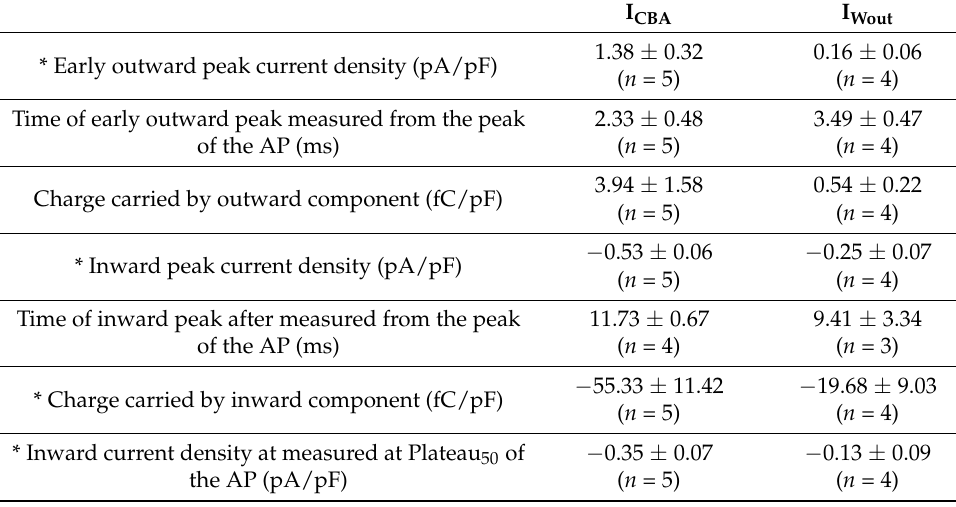
Table 2. Parameters of CBA- and washout-sensitive currents in APVC experiments. Significant differences between the values of I CBA and I Wout of the given parameters are indicated with asterisks in front of the name of the